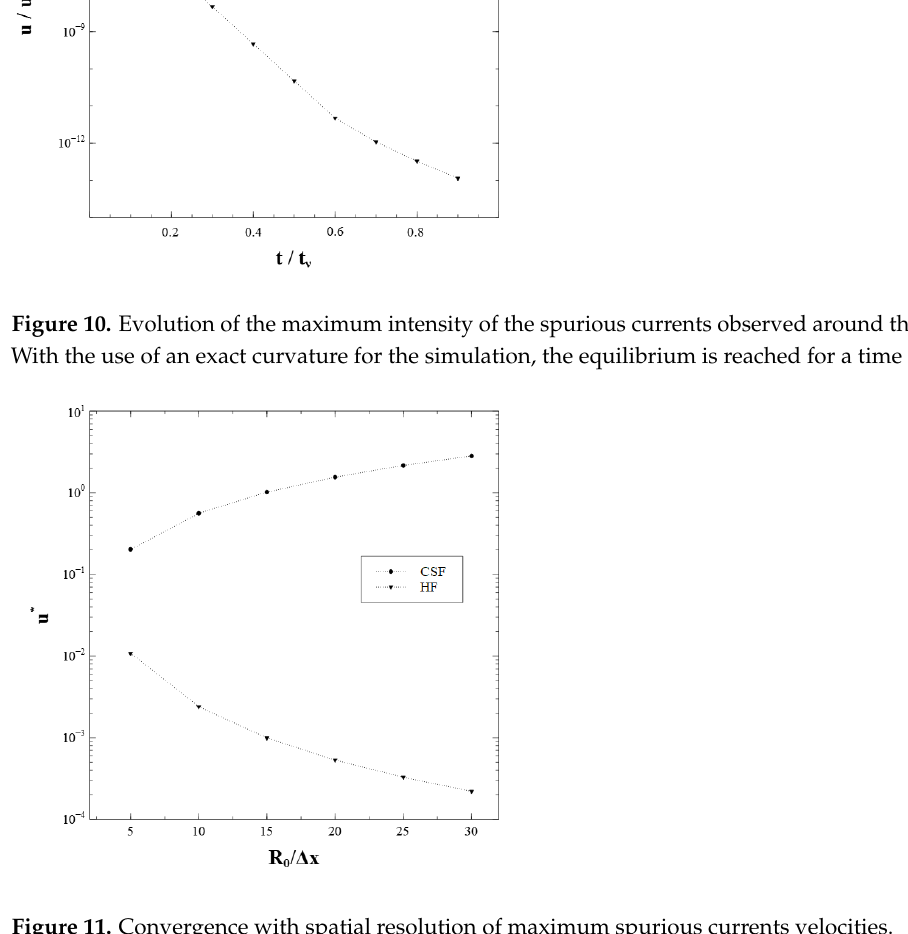
Figure 11. Convergence with spatial resolution of maximum spurious currents